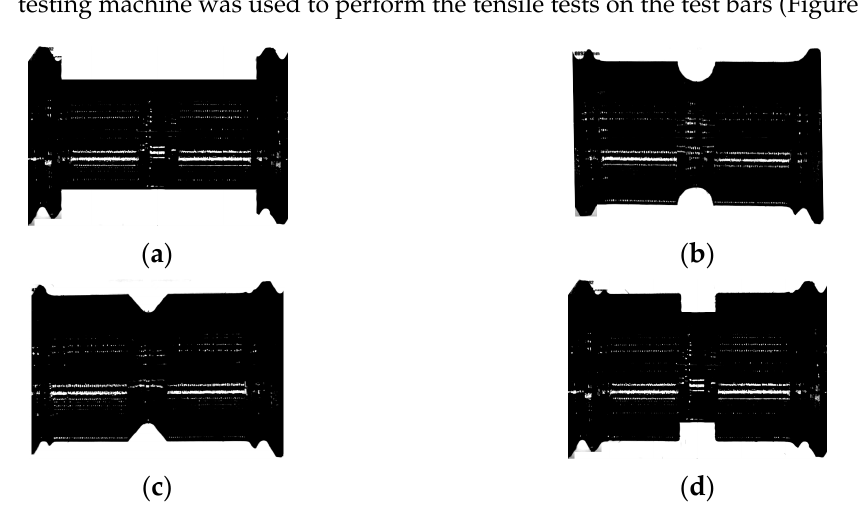
Figure 15. Projected images of the four tensile test bars. ( a ) Non-notch; ( b ) arc-shaped; ( c ) V-shaped; ( d ) square notch.